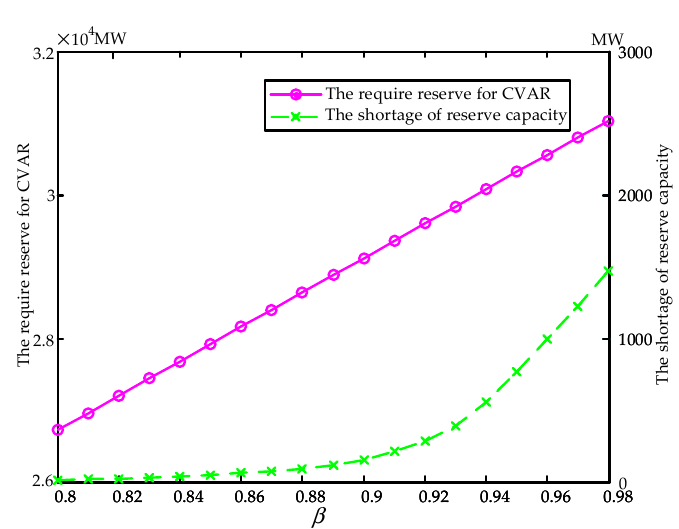
Figure 10. The optimization for the confidence level α . Energies 2018 , 11 , x